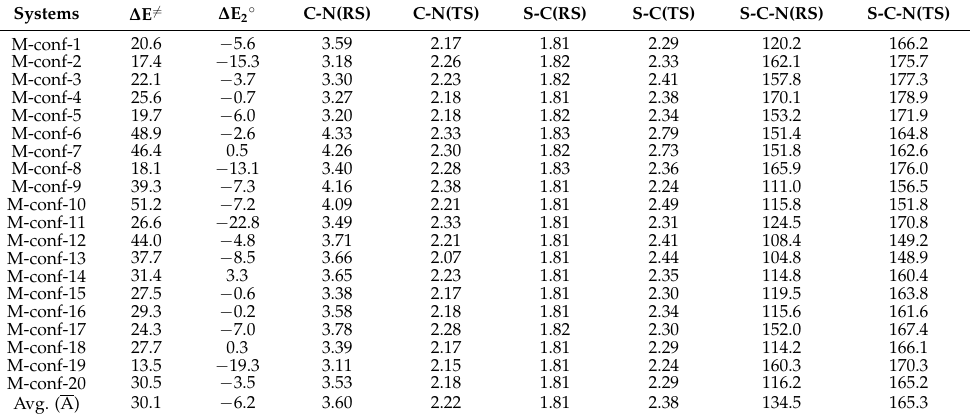
Table 3. Barrier heights ( ∆ E (cid:54) = ), reaction energies ( ∆ E 1 ◦ ) and selected geometric parameters for the conformations at the RS and TS for the methyl-transfer reaction carried out by MLL3. The C atom refers to the carbon from the methyl group of SAM and N to the nitrogen from Lys4 side chain. Energies are in kcal/mol, distances in Å, angles in degrees ( ◦ ) and energies in kcal/mol. M-conf-N indicates the monomer configuration, where N denotes the sampling window from which it was